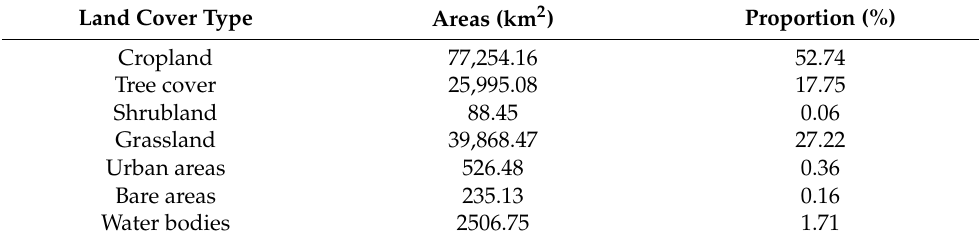
Table 1. Area and proportion of different land cover